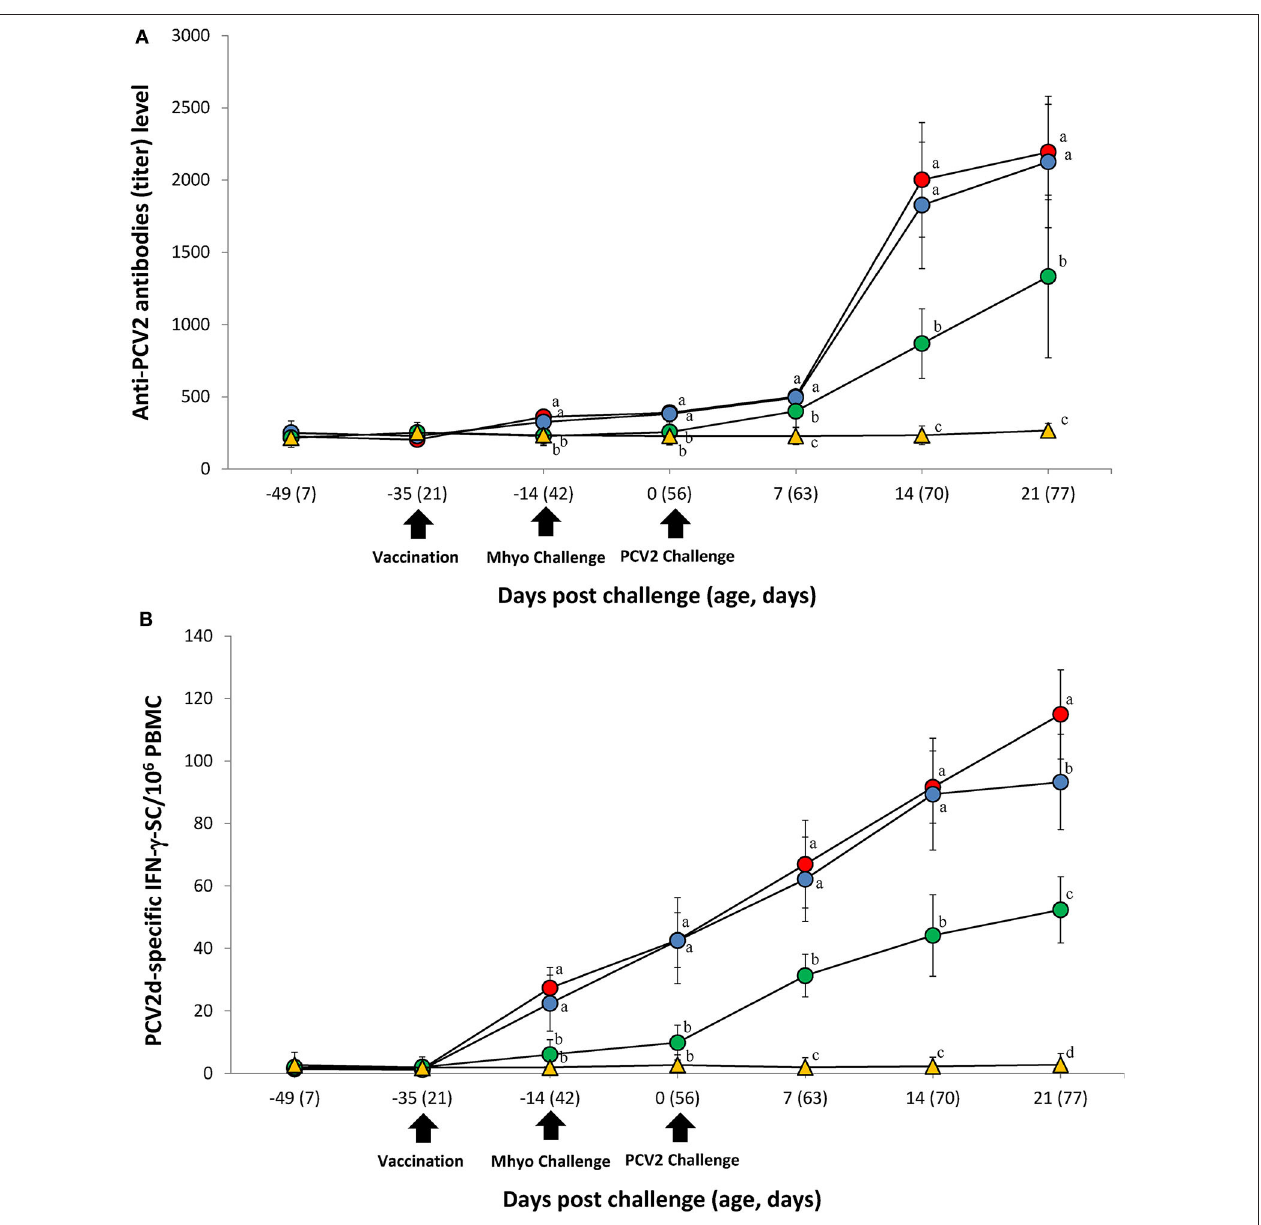
FIGURE 4 | Immune responses against porcine circovirus type 2 (PCV2). (A) Mean values of the PCV2 ELISA antibodies. (B) Frequency of PCV2d-specific interferon- γ secreting cells (IFN- γ -SC)/10 6 peripheral blood mononuclear cells (PBMC) in the different groups: VacA/Ch (•), VacB/Ch (•), UnVac/Ch (•), and UnVac/UnCh ( N ). Variation is expressed as the standard deviation. Different letters within a sampling point mean statistically significant differences ( P <